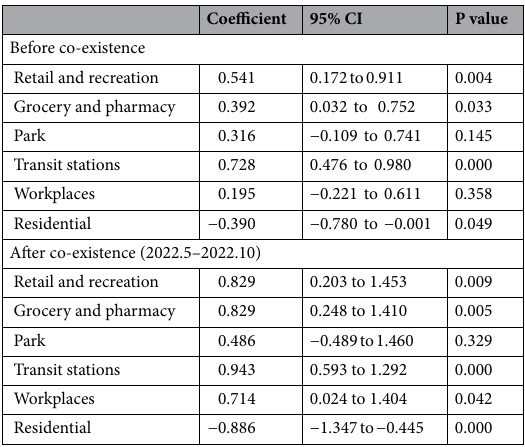
Table 2. Relationship of changes in population mobility at various locations with the monthly operating income of